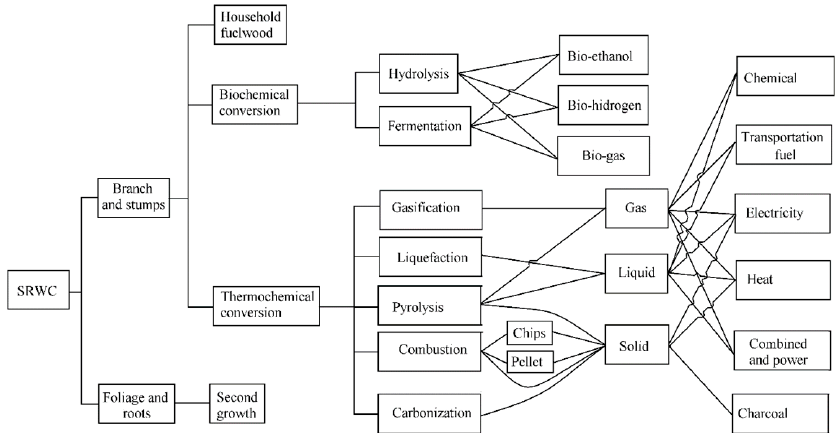
Figure 4. Route of conversion and possible final products of biomass generated in short-rotation woody crops in Latin America [31,107 – 109].